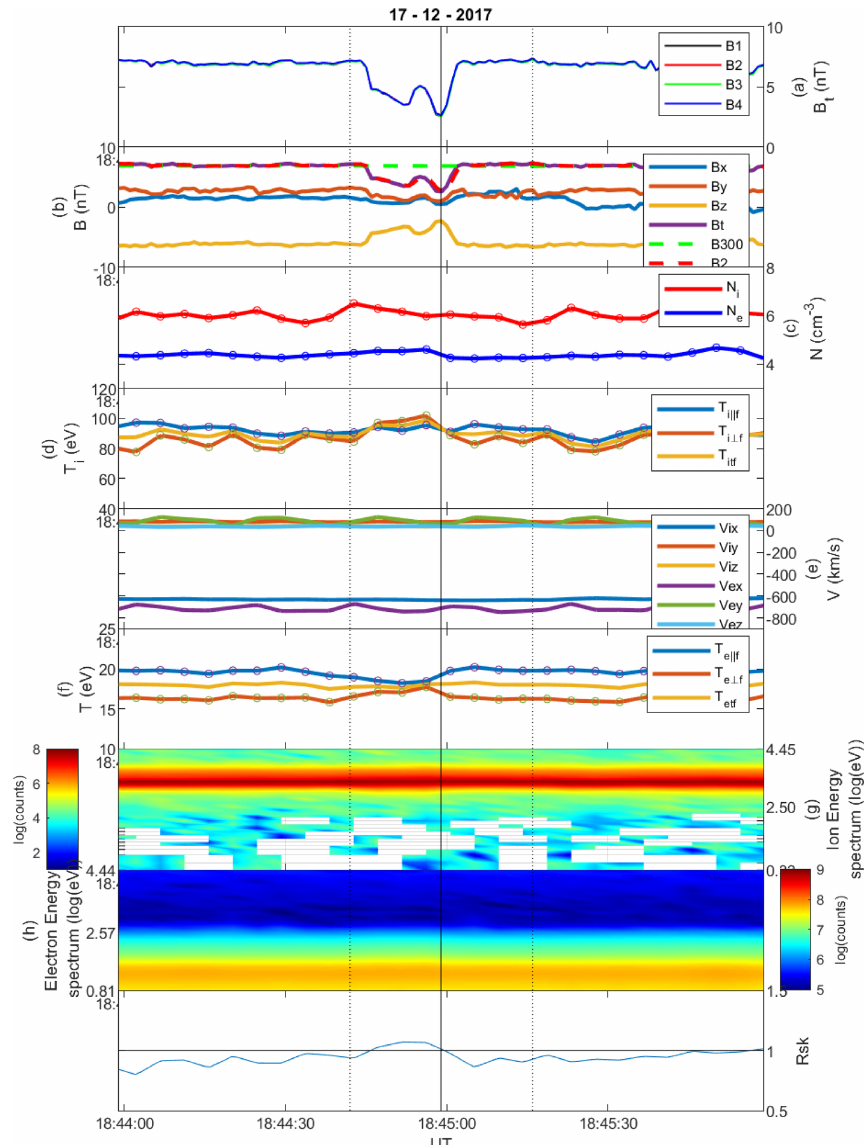
Figure 7. Linear magnetic hole on 17 December 2017, category hot. Format as in Fig. 1.